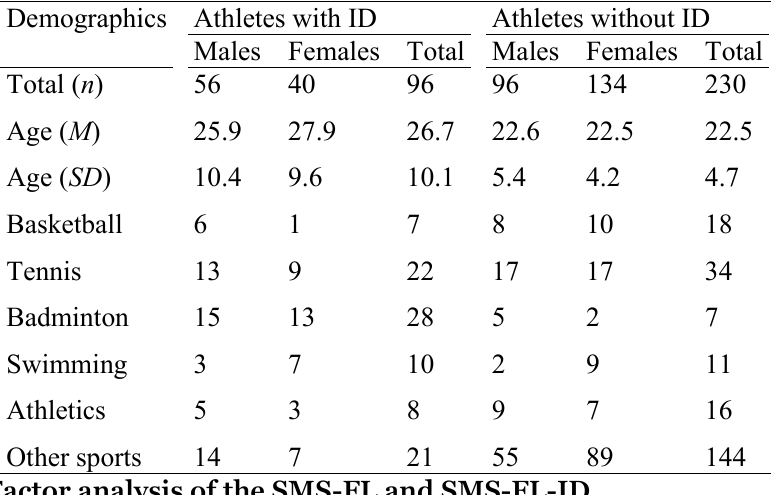
Table 1. Descriptive information of both